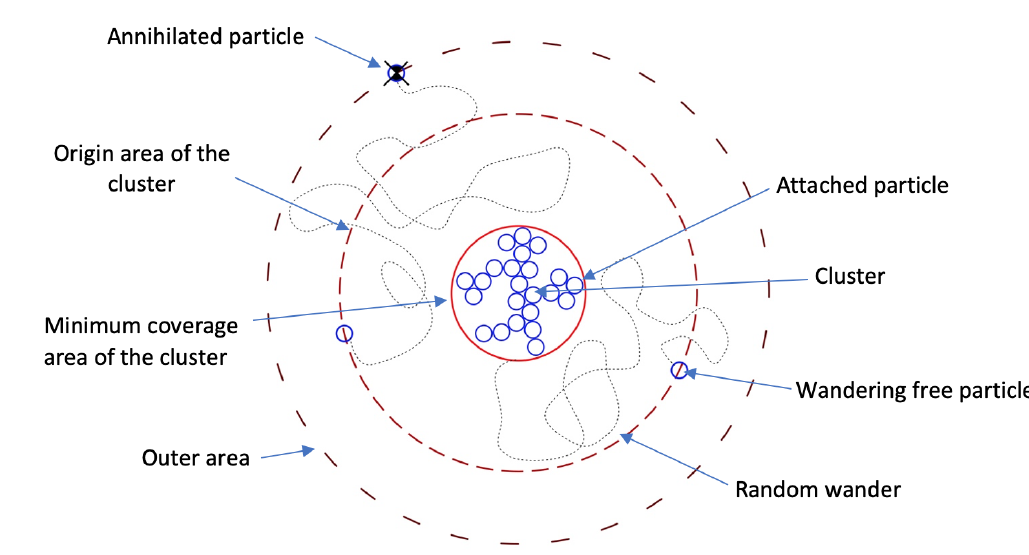
Figure 2. The schematic concept of the DLA growth algorithm with a minimum specified coverage area .